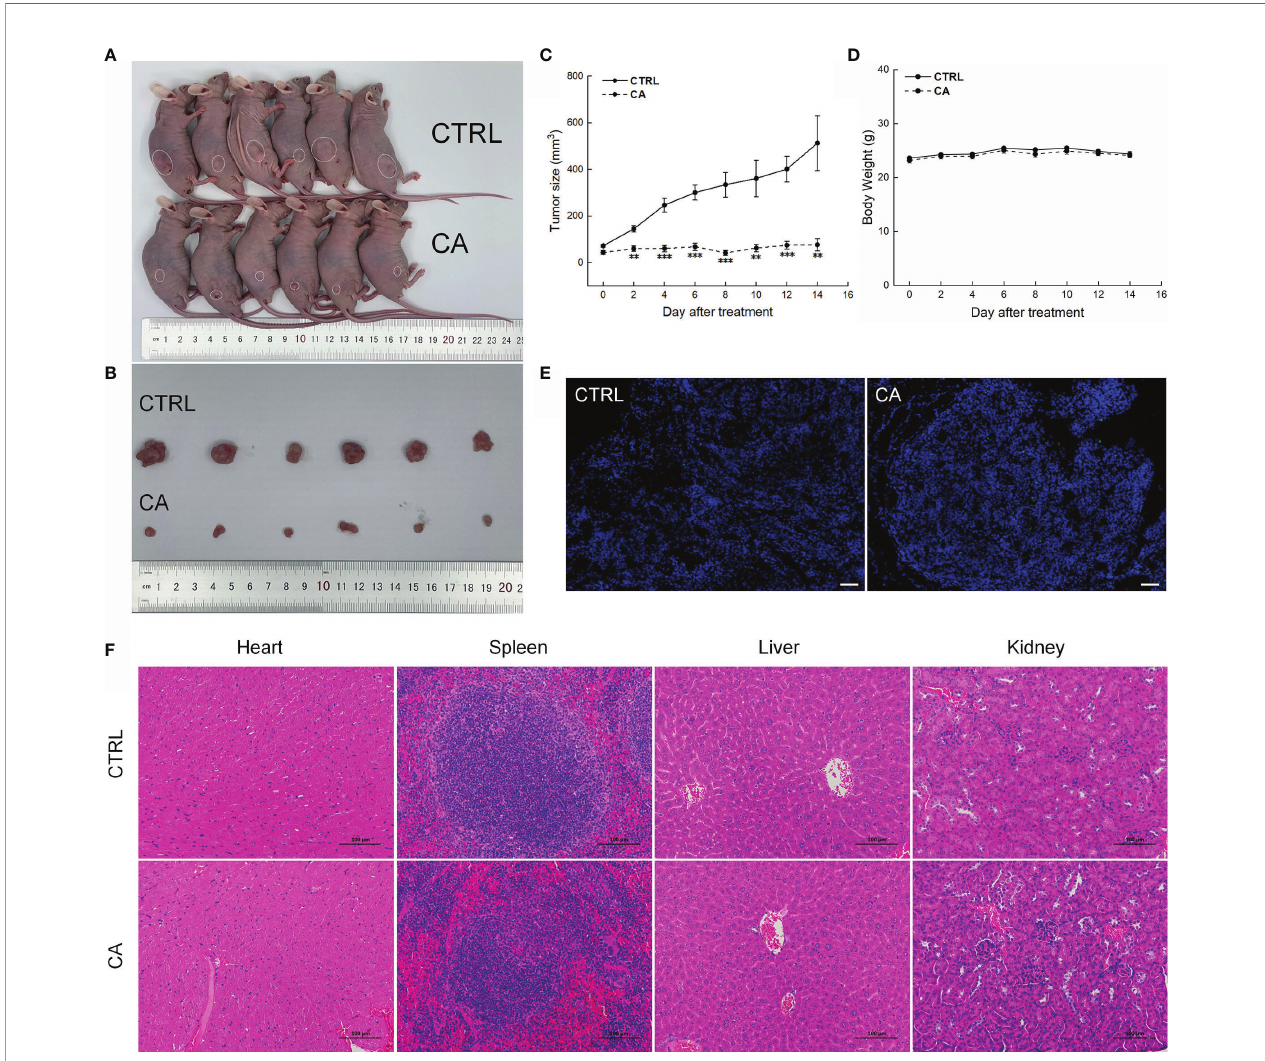
FIGURE 5 | CA treatment inhibited the tumor growth in BALB/c nude mice transplanted with SCC9 cells. CA treatment signi fi cantly reduced tumor volumes in (A) tumor-bearing BALB/c nude mice and (B) tumor tissues collected from the control (CTRL) and CA-treated groups and (C) decelerated the tumor growth without affecting (D) the body weight of the mice ( n = 6). (E) The apoptosis of tumor tissues increased after CA treatment ( n = 3) (200× magni fi cation, scale bar: 50 m m), while (F) the heart, spleen, liver, and kidney showed no histological abnormality ( n = 3) (200× magni fi cation, scale bar: 100 m m). Green fl uorescence locates apoptotic cells. ** P < 0.01 and *** P < 0.001 versus the CTRL